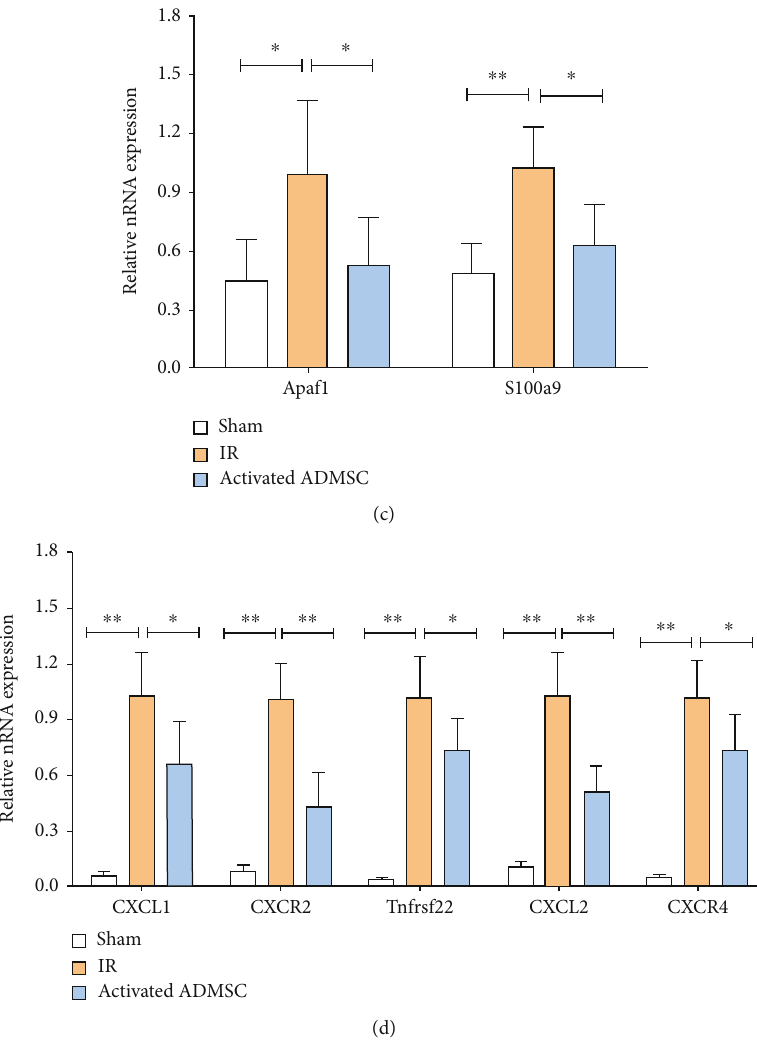
Figure 6: mRNA sequencing revealed that activated ADMSC treatment induced alteration of mRNA expression in comparison with the IR group. (a) Volcano plot showed di ff erentially expressed mRNAs between the activated ADMSC and IR groups. (b) Hierarchical clustering showed the top 100 deregulated mRNAs between the activated ADMSC and IR groups. (c, d) Results of real-time RT-PCR con fi rmed that seven mRNAs were upregulated in the IR group and down-regulated in activated ADMSC group, which was in lined with results from mRNA sequencing ( ∗ P < 0 : 05 , ∗∗ P < 0 : 01 , Bonferroni ’ s multiple